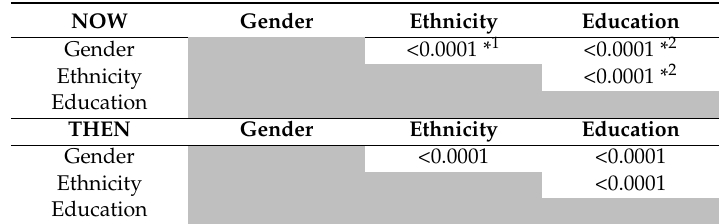
Table A1. Demographic 1.